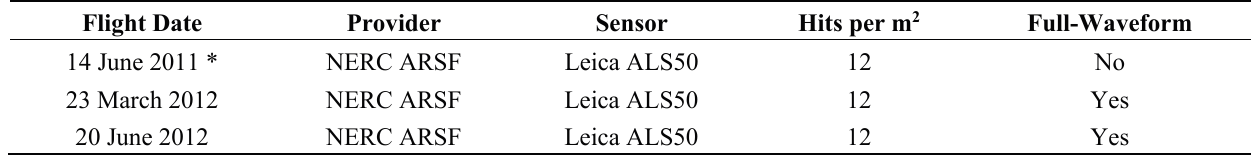
Table 1. ALS surveys undertaken by the NERC ARSF Leica ALS50-II small footprint system at each site (*14 June 2011 survey is for Diddington